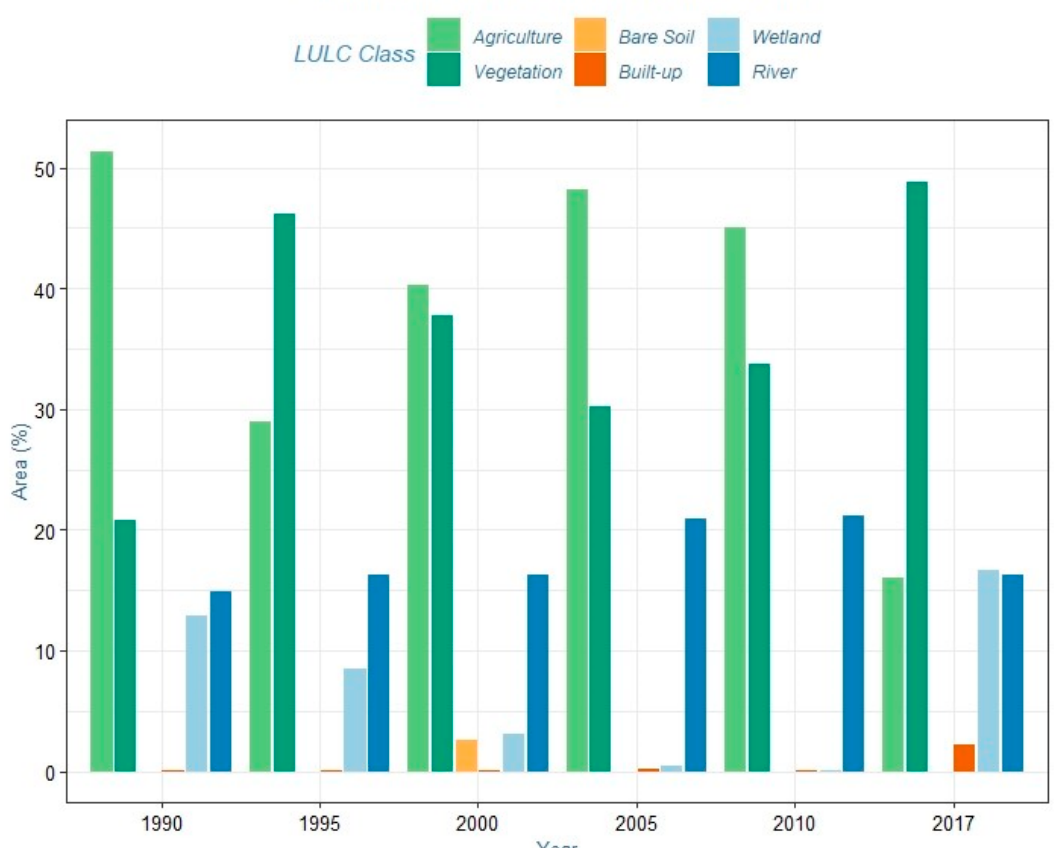
Figure A1. Percent area distribution of each land cover class between 1990 and 2017, obtained by the RF classifier